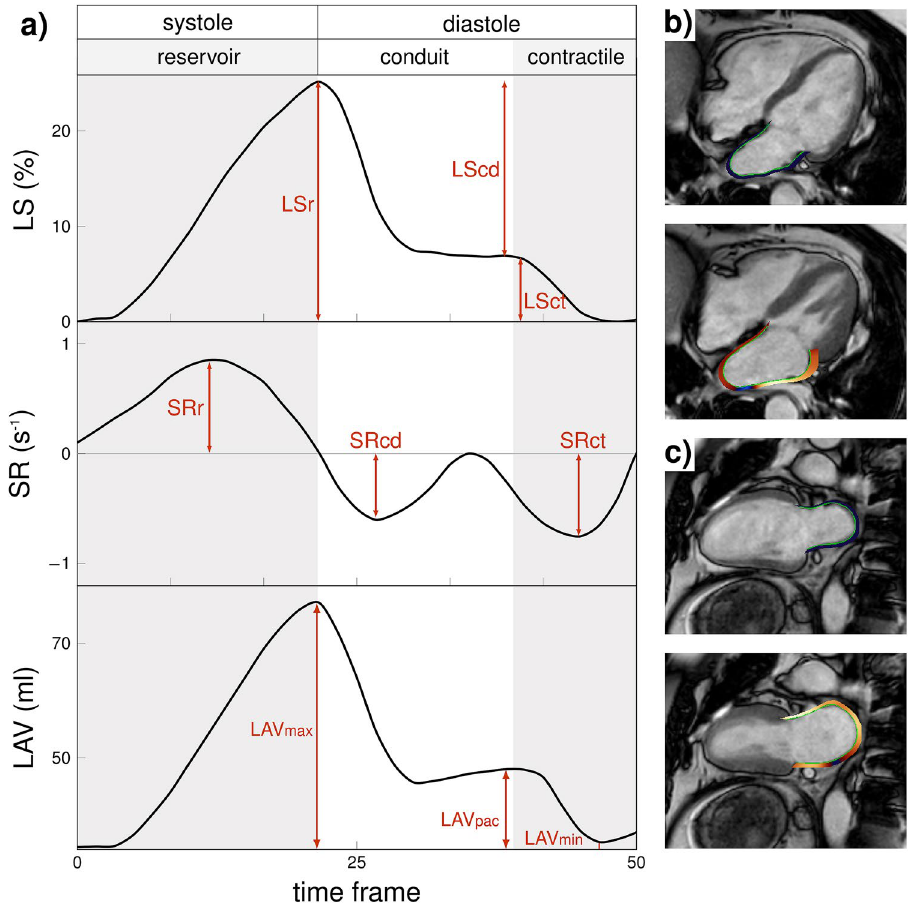
Figure 1. Representation of left atrial function parameters. ( a ) Illustrative representation of the left atrium (LA) strain (LS), strain rate (SR) and volume (V) with corresponding values according to the LA phase, measured with CMR-FT in a control subject. Example of one LA strain analysis performed in ( b ) four-chamber and ( c ) two-chamber views. Upper panel: Left ventricle (LV) end-diastole frame, lower panel: LV end-systole frame. cd conduit phase, ct contractile phase, CMR cardiovascular magnetic resonance, FT feature tracking, LA left atrium, LS longitudinal strain, LV left ventricle, pac pre-atrial contraction, SR strain rate, r reservoir